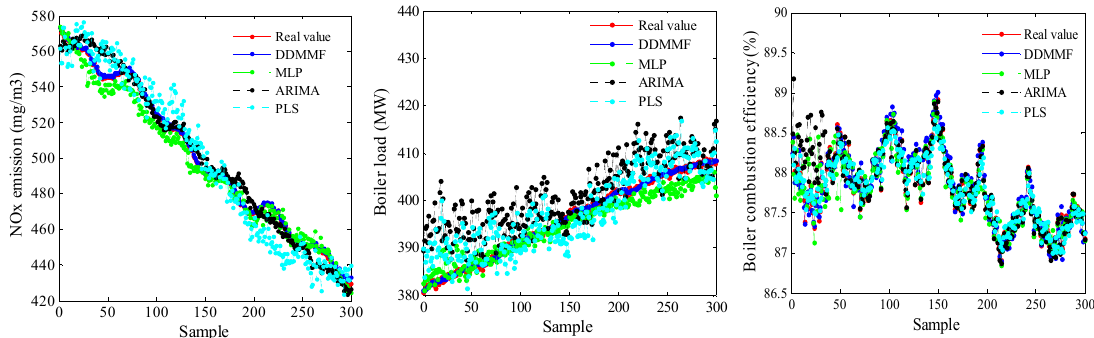
Figure 3. The predicted values obtained from different prediction models for operating condition 1.